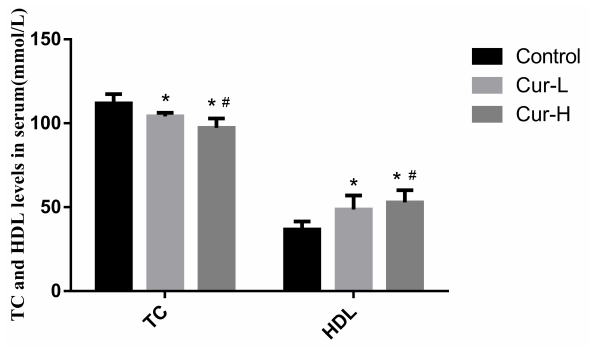
Fig. 3. Curcumin reduced the level of TC and increased HDL in the serum of APP/PS1 mice (# p > 0.05, versus Cur-L; * p < 0.05, versus Con-